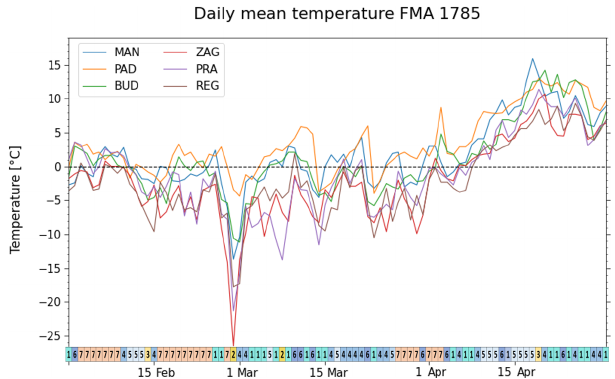
Figure 8. Daily mean temperature from February to April 1785 at six SMP locations: Mannheim, Padua, Budapest, ˙Zaga´n, Prague, and Regensburg. The bottom bar indicates the CAP7 weather type classifications by Schwander et al.